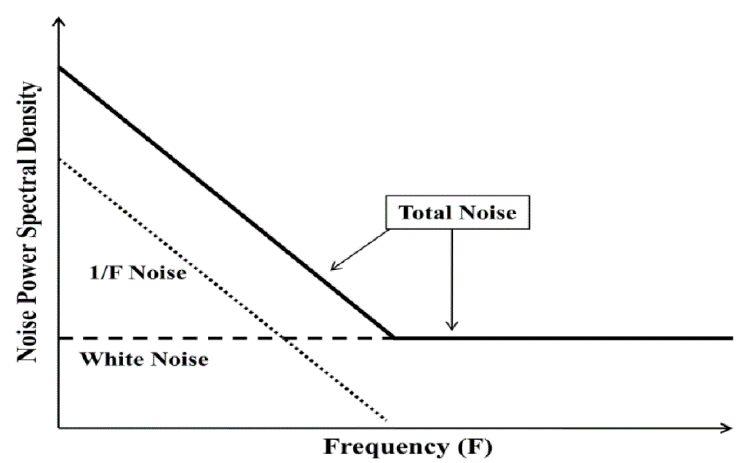
Figure 2. Schematic power spectral density (PSD) showing two types of noise as a function of frequency, white noise that is the same at all frequencies and 1/ f noise that is important only at low frequencies. Both axes in this schematic are linear. However, most noise data are presented on log PSD vs. linear or log F graphs because of the wide variations in the noise intensity. Most experimental noise spectra are not as simple, but they often show these general